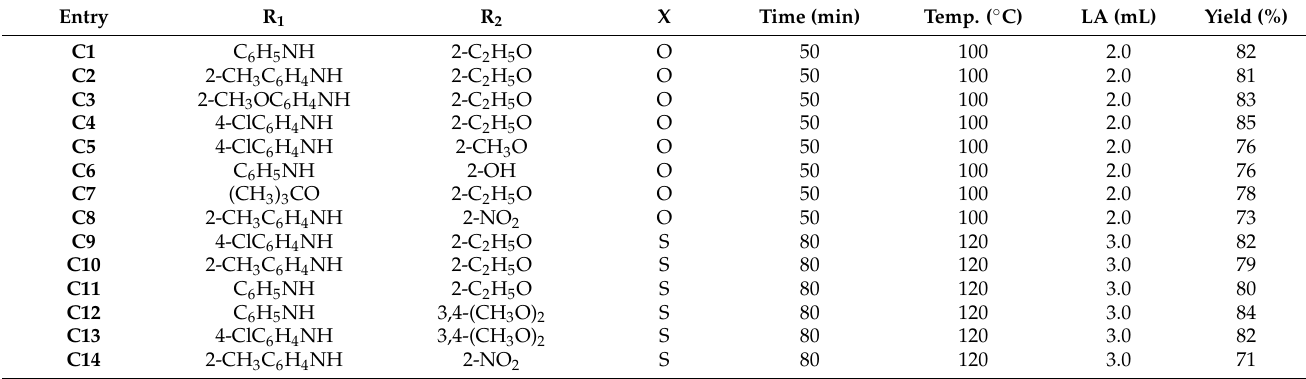
Table 2. Optimization of reaction conditions for solvothermal synthesis of dihydropyrimidinones ( D1 – D16 ) a